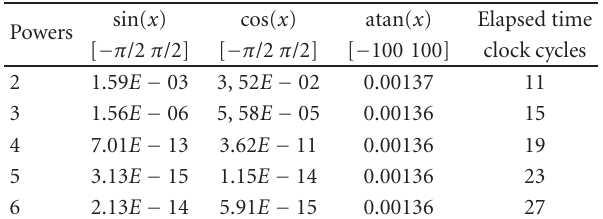
Table 3: MSE and Latency of the FP Taylor architecture.